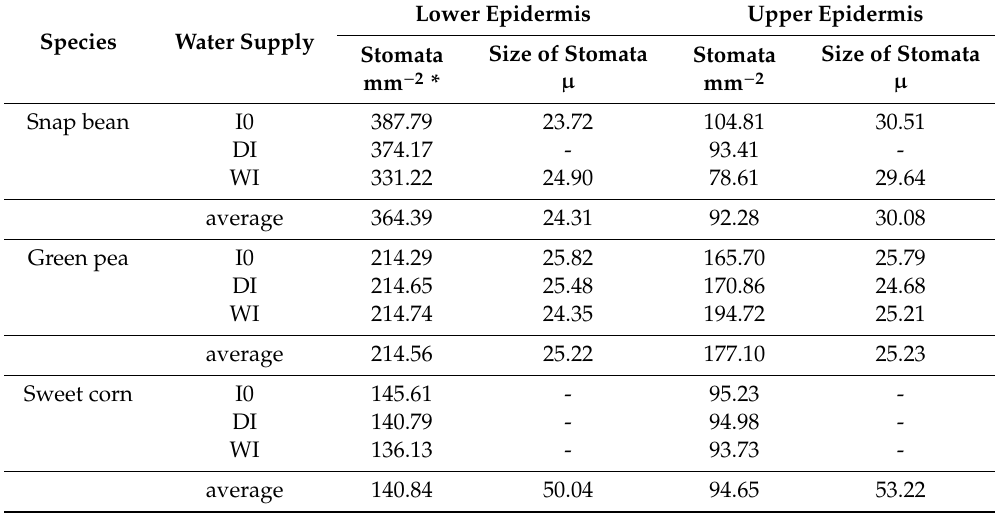
Table 2. Size and density of stomata measured during generative stages of vegetable crops under di ff erent water supplies Source: modified from Nemesk é ri et al.